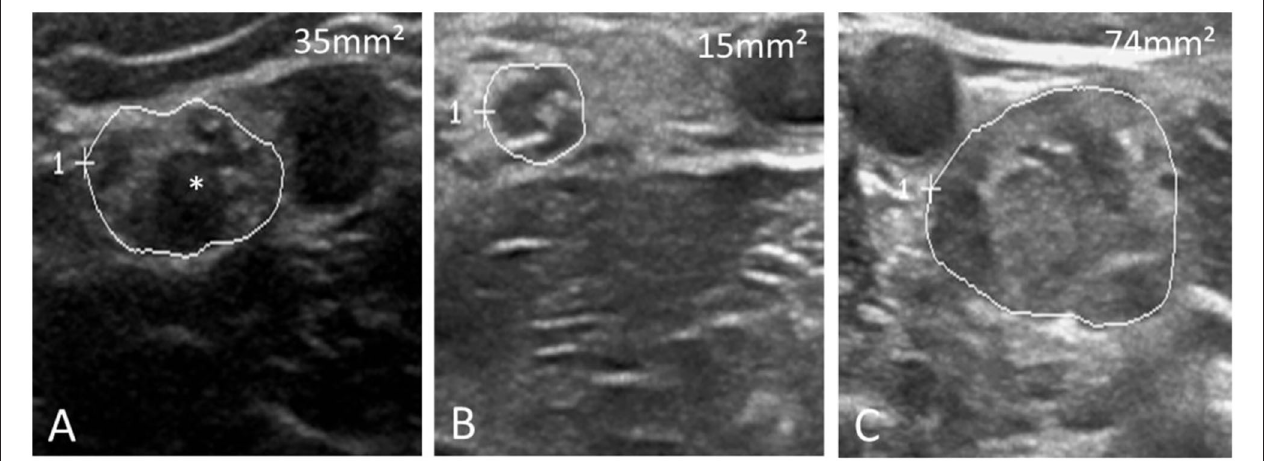
FIGURE 1 | Three distinct ultrasound morphologies in chronic inflammatory demyelinating polyneuropathy. (A) Shows an enlarged median nerve (MN, CSA 35 mm 2 , normal values 13 mm 2 ) with reduced echointensity and enlarged fascicles (*), while (B) Shows an only slightly enlarged nerve without fascicle enlargement (CSA 15 mm 2 ). In contrast, in (C) the MN is tremendously enlarged (74 mm 2 ) with otherwise hyperechoic intraneural echo signature. (A) Resembles the most common nerve morphology in chronic inflammatory demyelinating